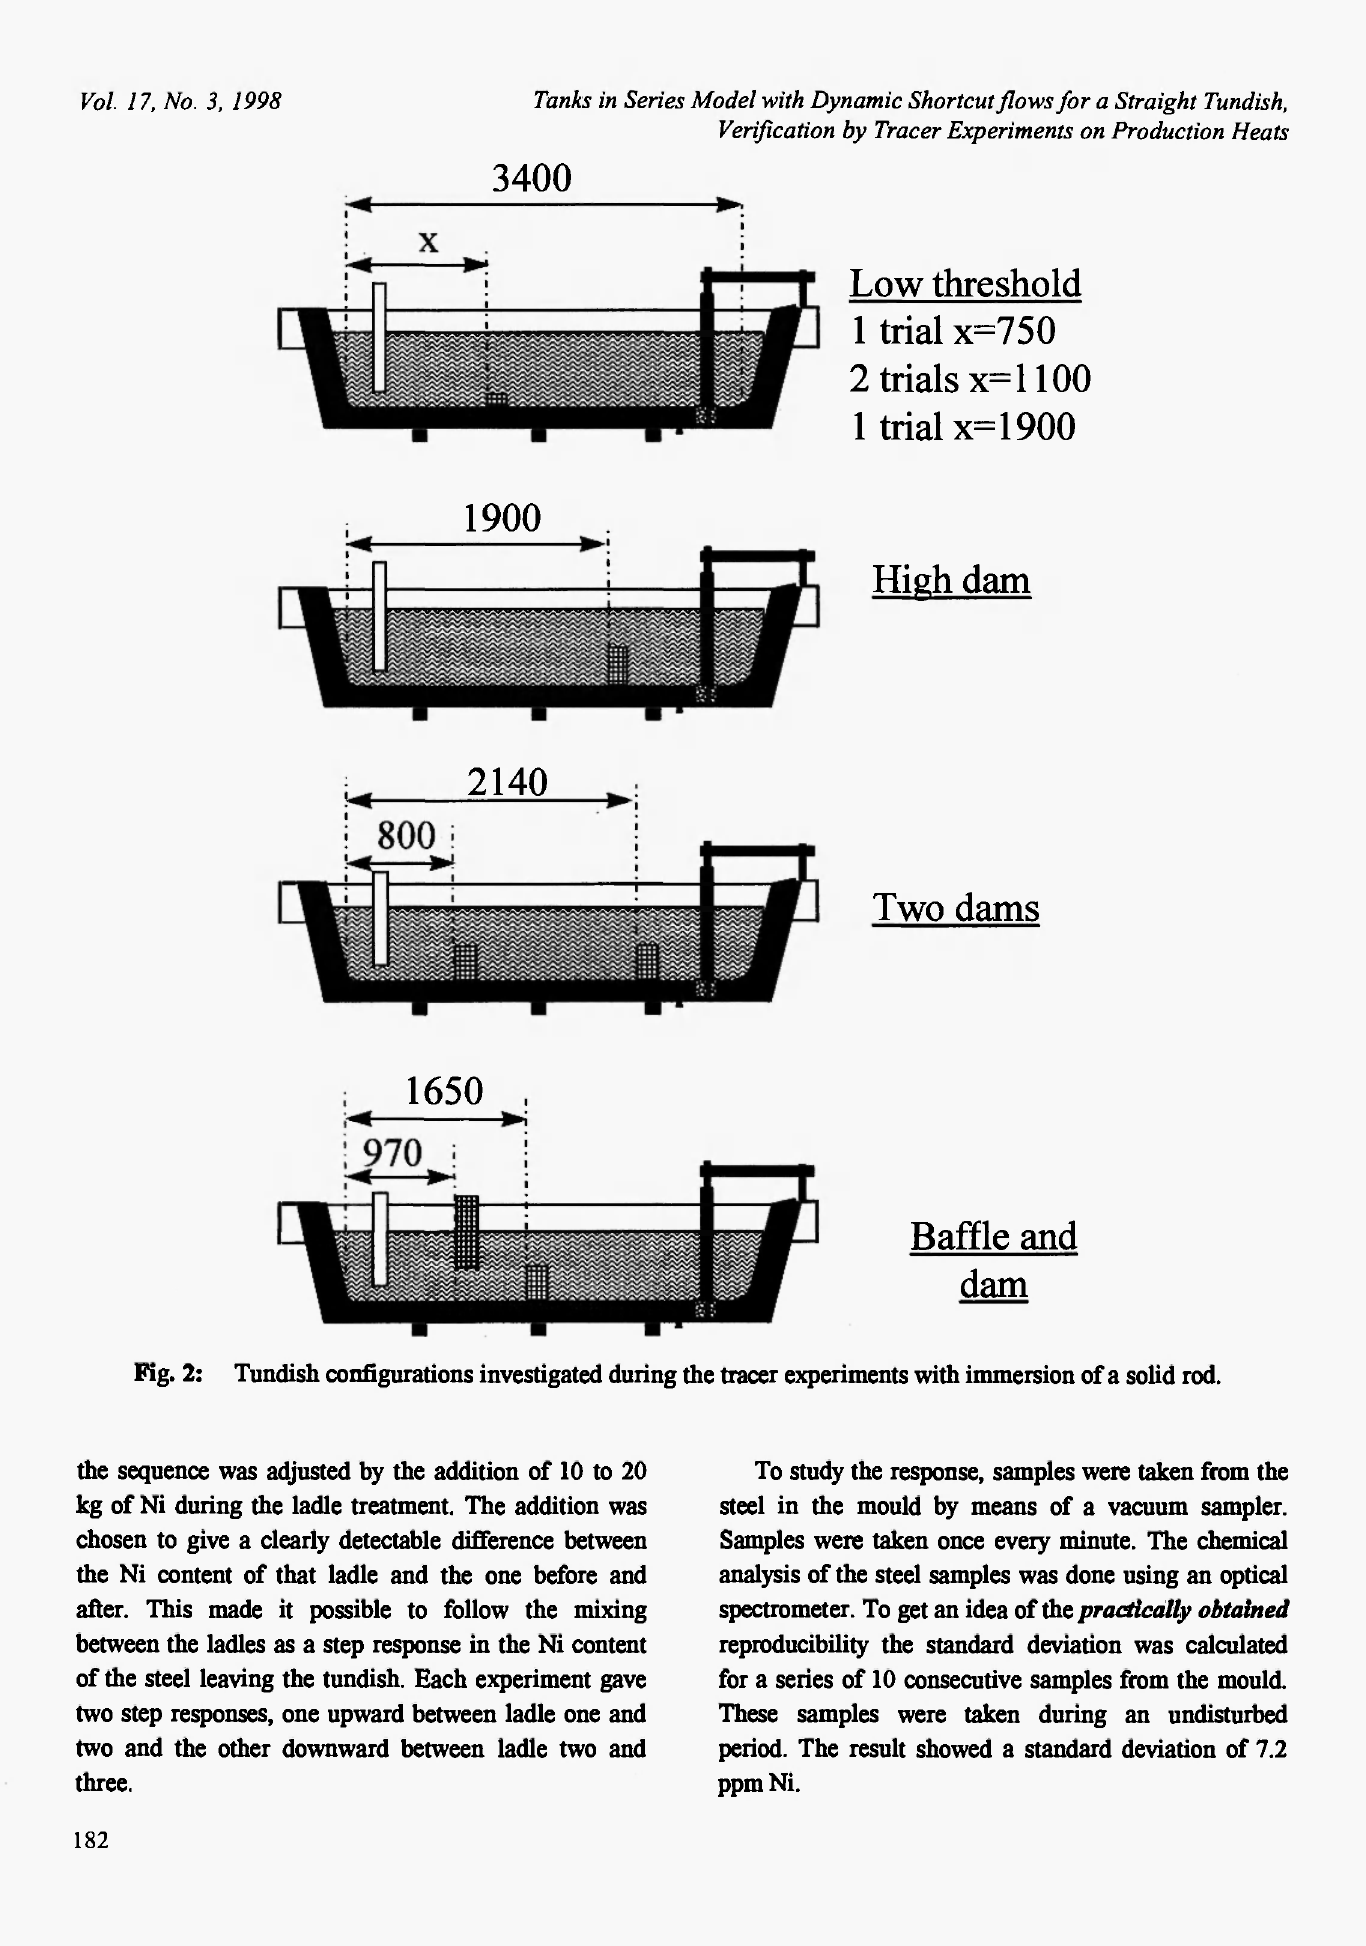
To study the response, samples were taken from the steel in the mould by means of a vacuum sampler. Samples were taken once every minute. The chemical analysis of the steel samples was done using an optical spectrometer. To get an idea of the practically obtained reproducibility the standard deviation was calculated for a series of 10 consecutive samples from the mould. These samples were taken during an undisturbed period. The result showed a standard deviation of 7.2 ppm